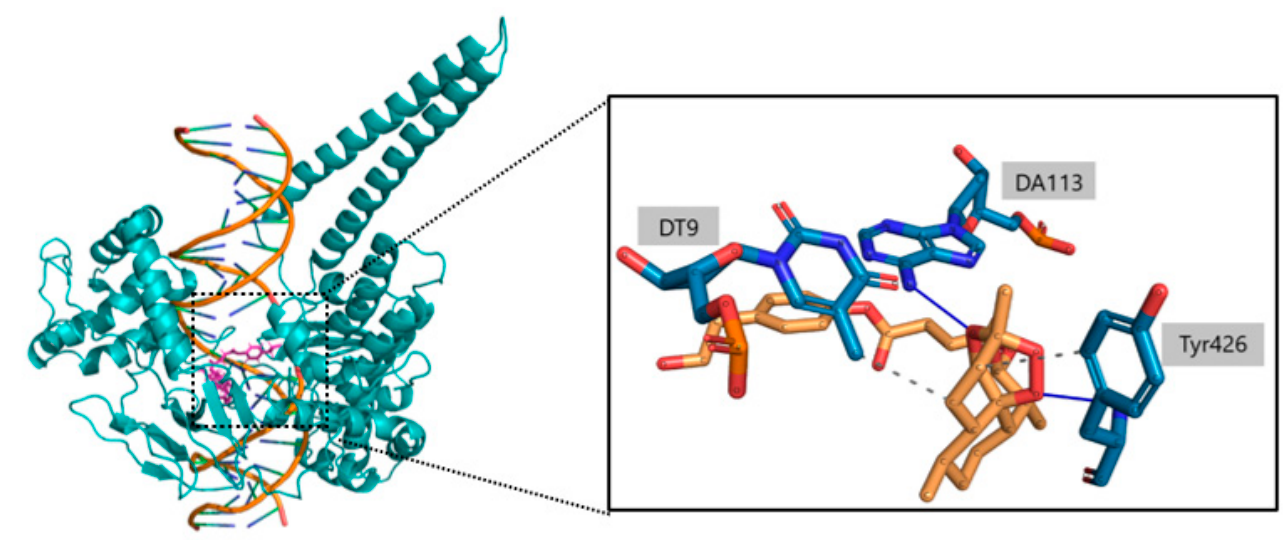
Figure 11. Right: 3D structures of compound c7 housed within the receptor pocket. Left: Highlighted are the atoms most involved in the formation of noncovalent interactions (hbonds in blue, hydrophobic bonds with dashed line) with the amino acids and nucleotides of the 1T8I receptor (belonging to the core-subdomain I portion of the protein and with the DNA double helix).